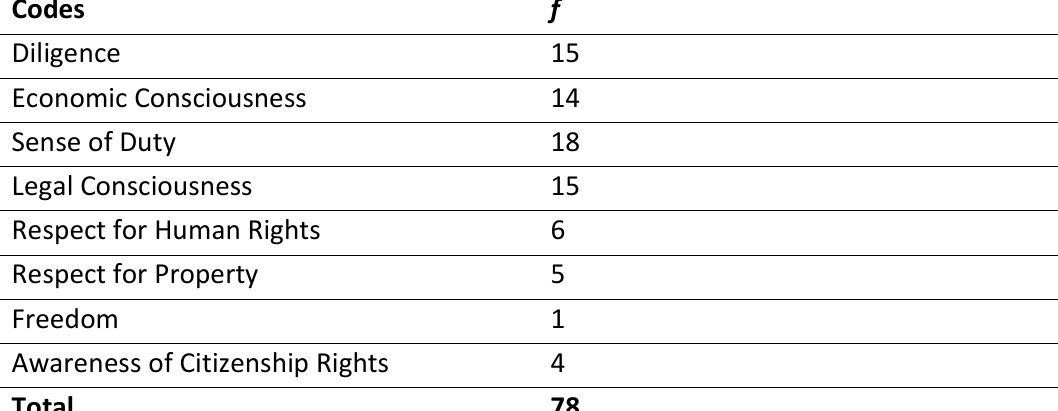
Table 9 . Codes and Statistics of Rights and Responsibilities